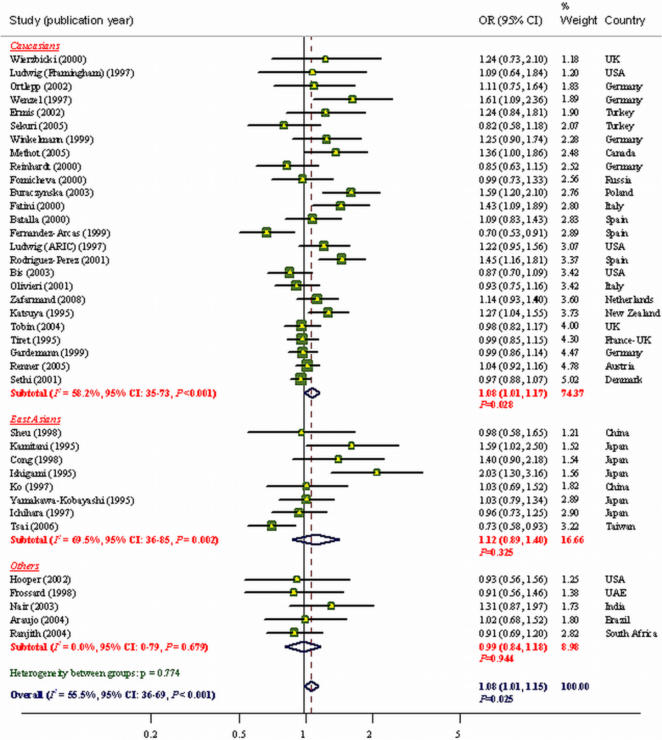
Results of published studies of association between the M235T polymorphism in AGT gene and coronary heart disease in different ethnic groups.ORs for the outcome compared the T235 allele vs. the M235 allele (Additive model). The size of the box is proportional to the weight of the study. Given P-values for odds ratios are based on DerSimonian-Laird method using a random effects model and for heterogeneity in different ethnic groups are based on Q-test.